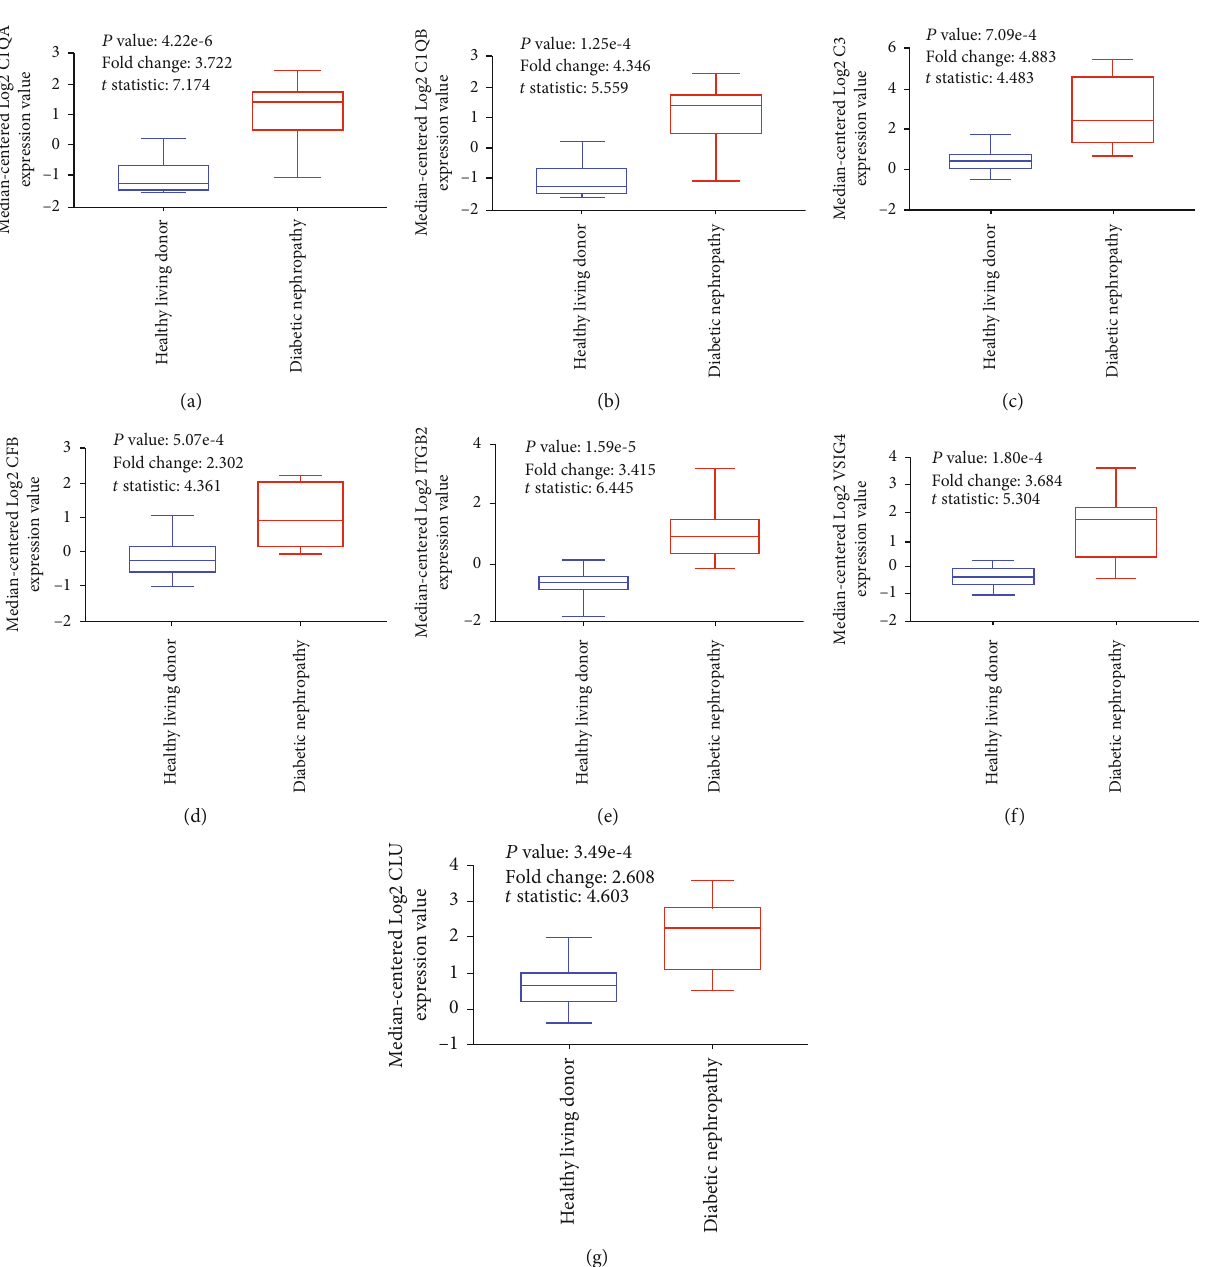
Figure 9: The di ff erent expressions of complement cascade-related hub genes (C1QA, C1QB, C3, CFB, ITGB2, VSIG4, and CLU) in DN renal tissues and healthy kidney tissues. (a) The expression of C1QA in DN renal tissues is higher than in healthy kidney tissues. (b) The expression of C1QB in DN renal tissues is higher than in healthy kidney tissues. (c) The expression of C3 in DN renal tissues is higher than in healthy kidney tissues. (d) The expression of CFB in DN renal tissues is higher than in healthy kidney tissues. (e) The expression of ITGB2 in DN renal tissues is higher than in healthy kidney tissues. (f) The expression of VSIG4 in DN renal tissues is higher than in healthy kidney tissues. (g) The expression of CLU in DN renal tissues is higher than in healthy kidney